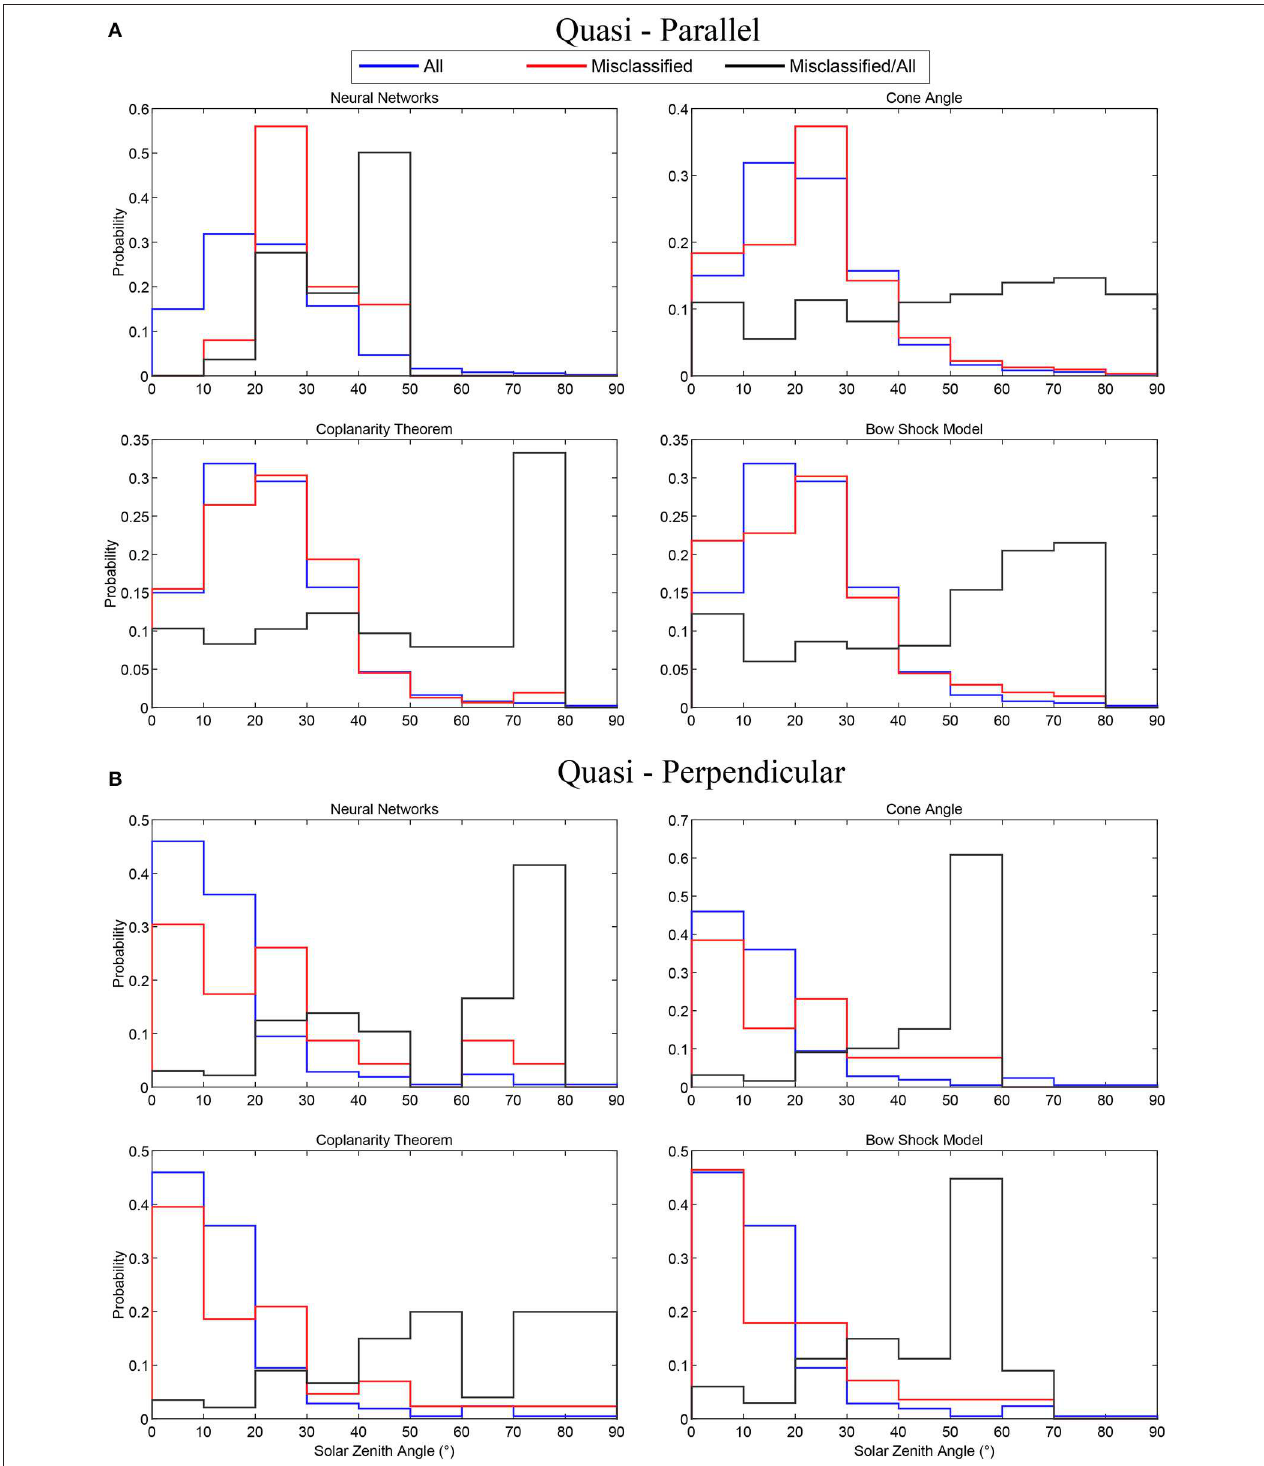
FIGURE 9 | Histograms showing the relative position of jets in the magnetosheath (solar zenith angle). Blue lines represent the whole number of jets, Red show the misclassified jets and black show the misclassified cases normalized over the whole number of jets. (A) : Quasi-parallel jets ( n = 860). (B) : Quasi-perpendicular jets ( n =